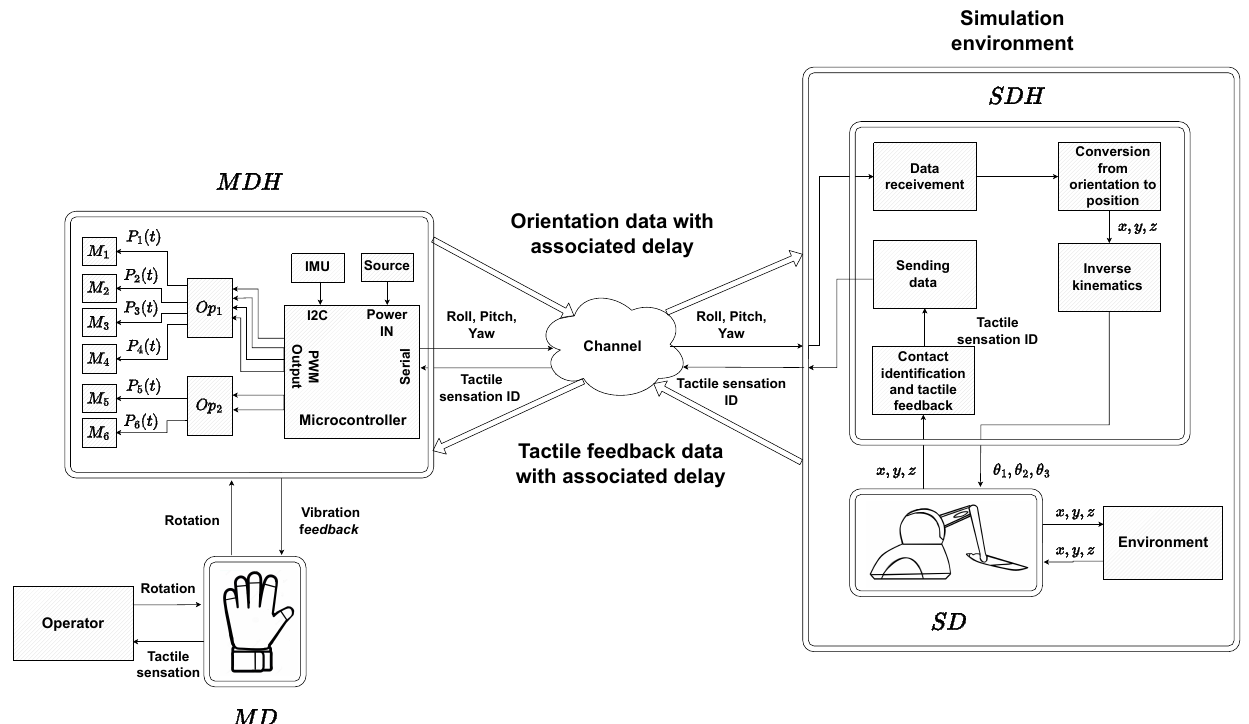
Figure 1. Proposed tactile platform